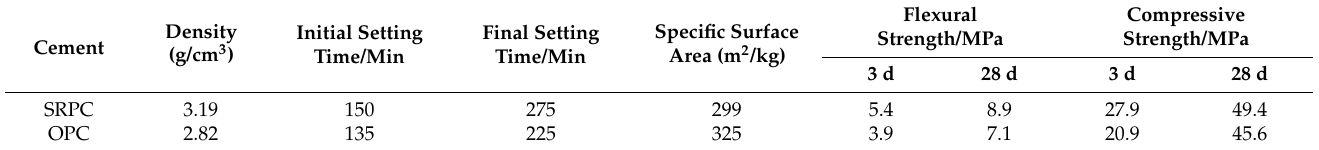
Table 2. Physical properties of the